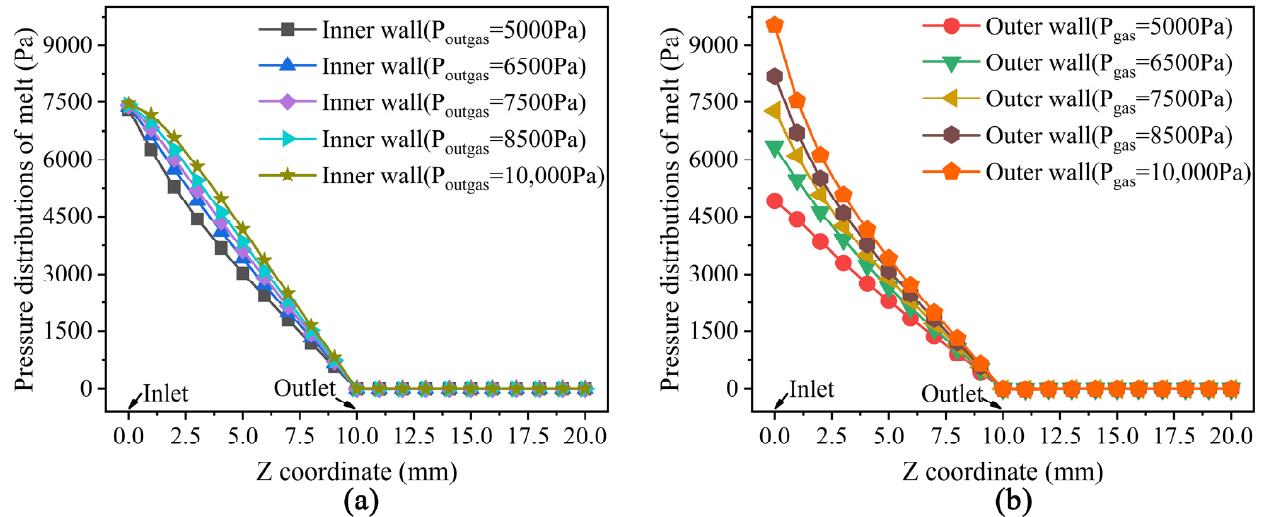
Figure 6. The distribution of melt pressure under different pressure of the outer gas cushion layer. ( a ) Pressure at inner surface of the melt; ( b ) Pressure at outer surface of the melt.